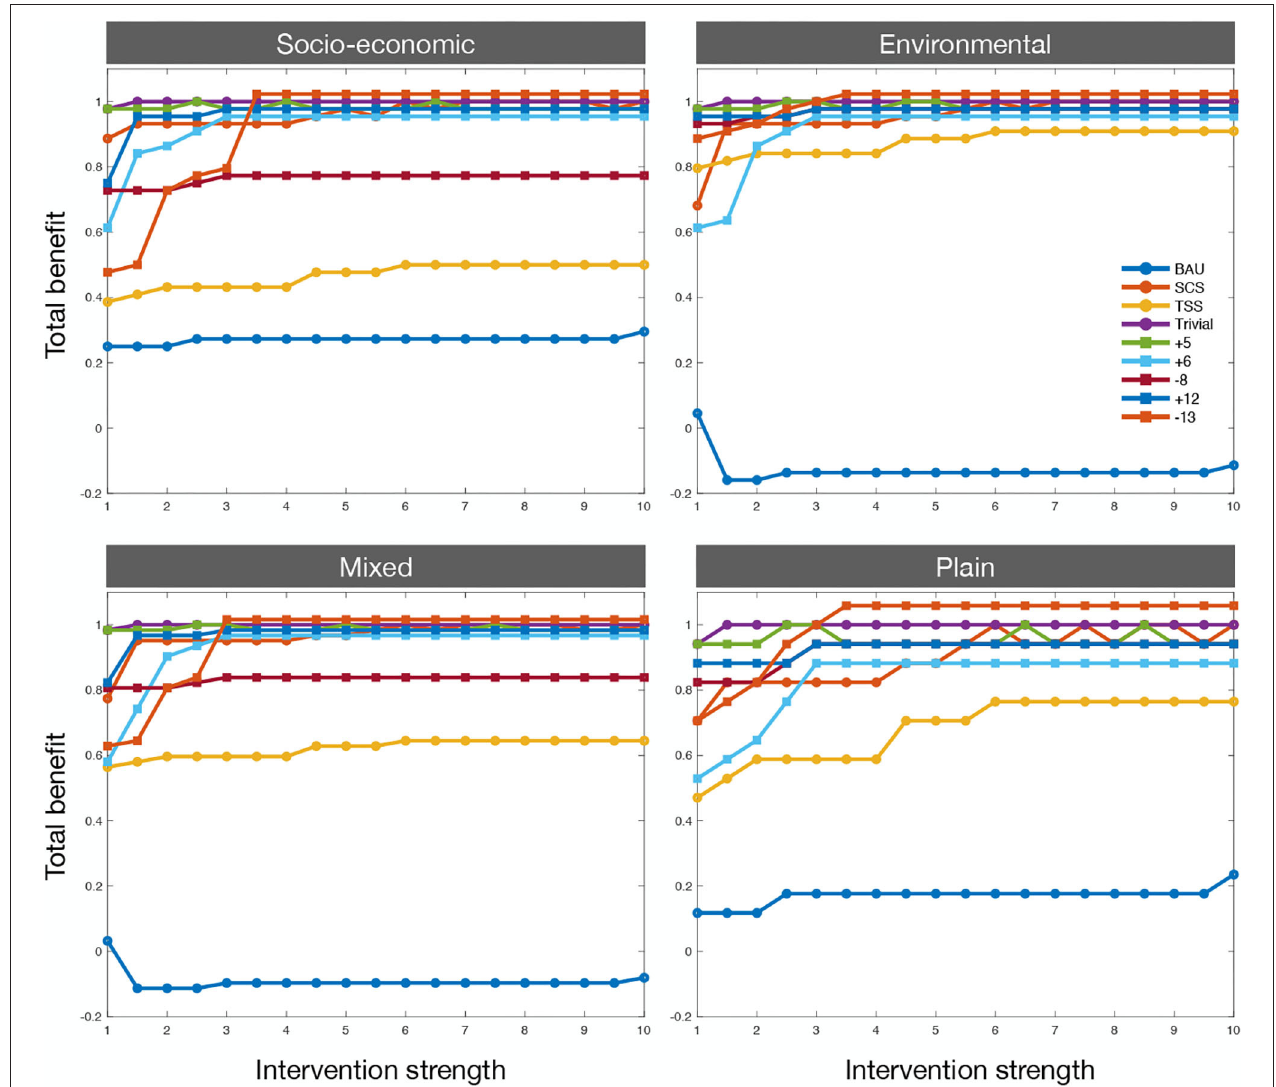
FIGURE 3 | Total benefit projected for the tested public policy scenarios, at various levels of intervention strength. Circles show aprioristic scenarios: BAU, SCS, TSS, trivial. Squares show aposterioristic scenarios: increasing ( + ) or decreasing ( − ) variables 5, 6, 8, 12, and 13. Each plot shows the results for a defined strategic priority: socio–economic, environmental, mixed, and